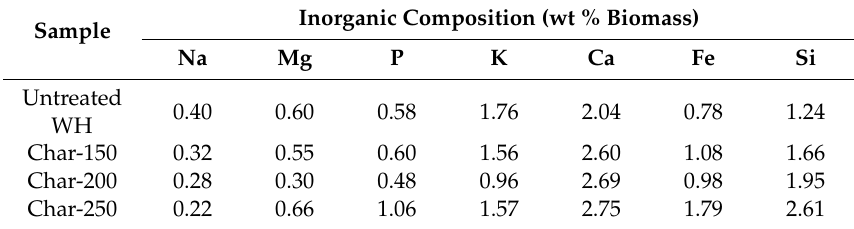
Table 3. Major inorganic elemental composition of untreated water hyacinth (WH) and hydrochars. Sample